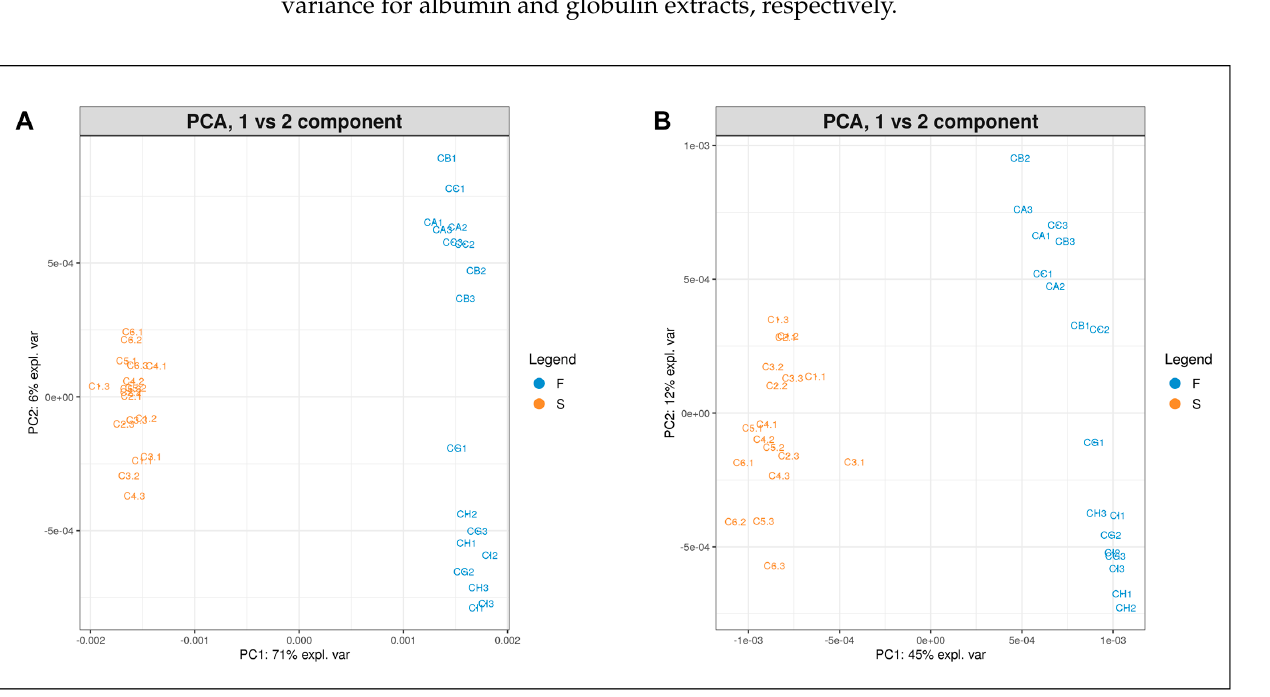
Table 4. Mass signals from albumin and globulin extracts of certified seeds corresponding to the top 25 loadings on PC1 and their correlation with plant variety. Protein Extract